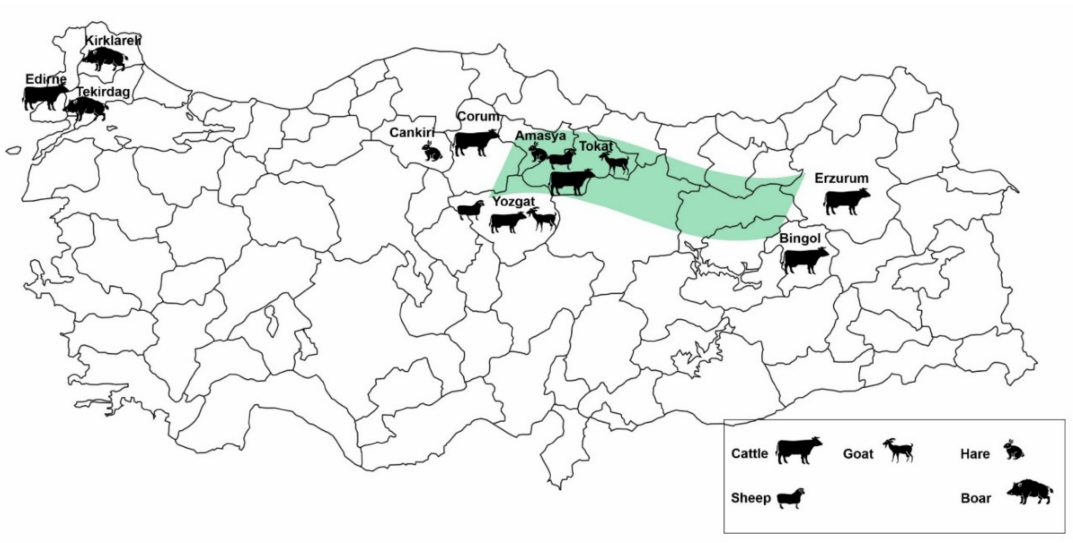
Figure 1. The study area of wild and domestic animals in Turkiye. The green represents the endemic region (Kelkit Valley) of CHHFV in Turkiye.